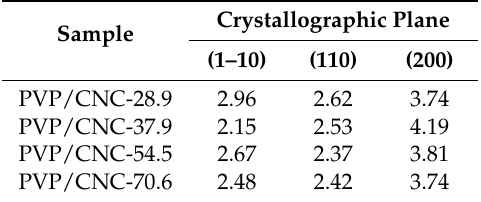
Table 4. CNC crystallite sizes (nm) in the PVP/CNC composite films.